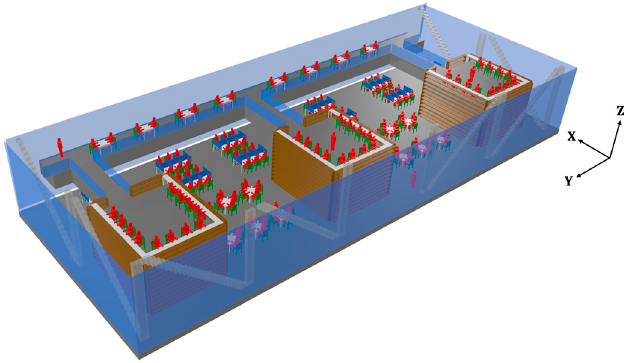
Figure 4. Rendered view of the simulated scenario by means of the 3D-RL technique.